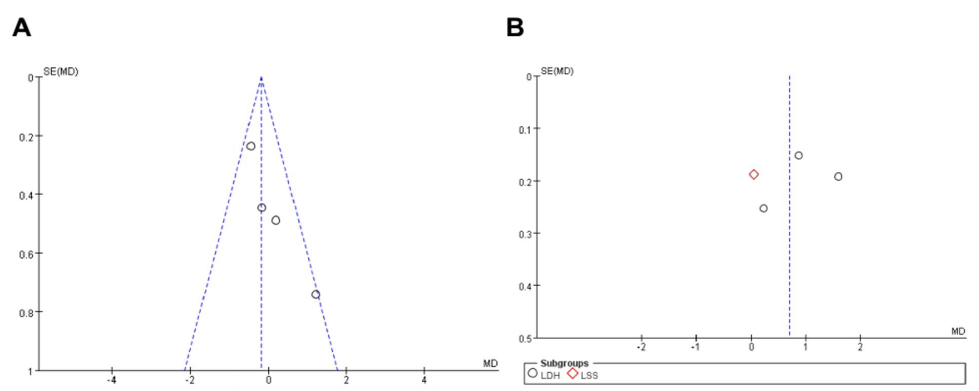
Figure 7. Funnel chart of publication bias ( A ) length of hospital stay; ( B ) VAS for back (within 3